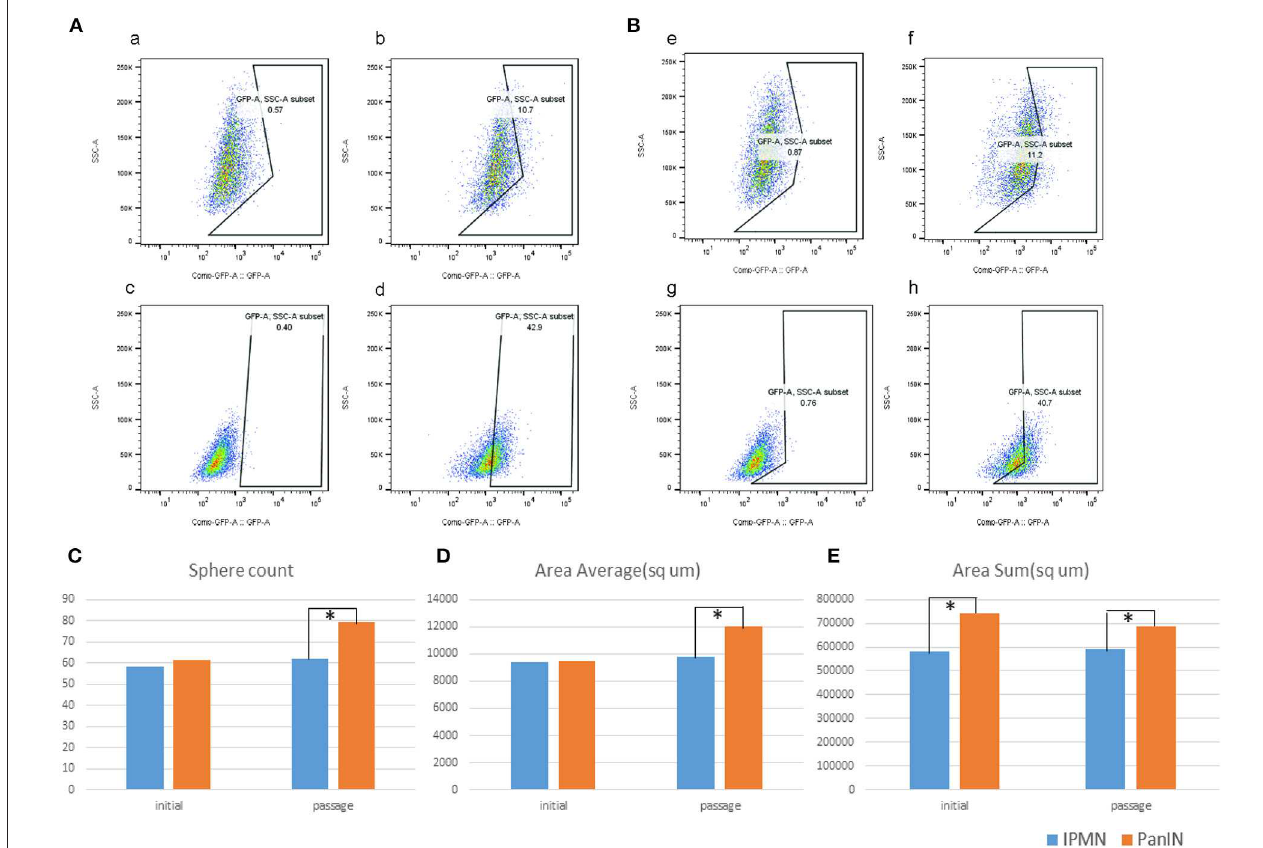
FIGURE 6 | Green fluorescent protein (GAP)-conjugated ALDH + and DAPI (detection of dead cells) were detected by flow cytometry; right, the fraction of ALDH + cells (GFP + , DAPI negative) (b,d,f,h) vs. left, as the background correction. Upper were cells from intraductal papillary mucinous neoplasm (IPMN); lower were cells from pancreatic intraepithelial neoplasia (PanIN). In separate condition of 5 × 10 5 cells/ml (A) and 2 × 10 5 cells/ml. (B) Sphere digitalization by cell 3 imager. Sphere count (C) , area average/ µ m 2 (D) , and area sum/ µ m 2 (E)